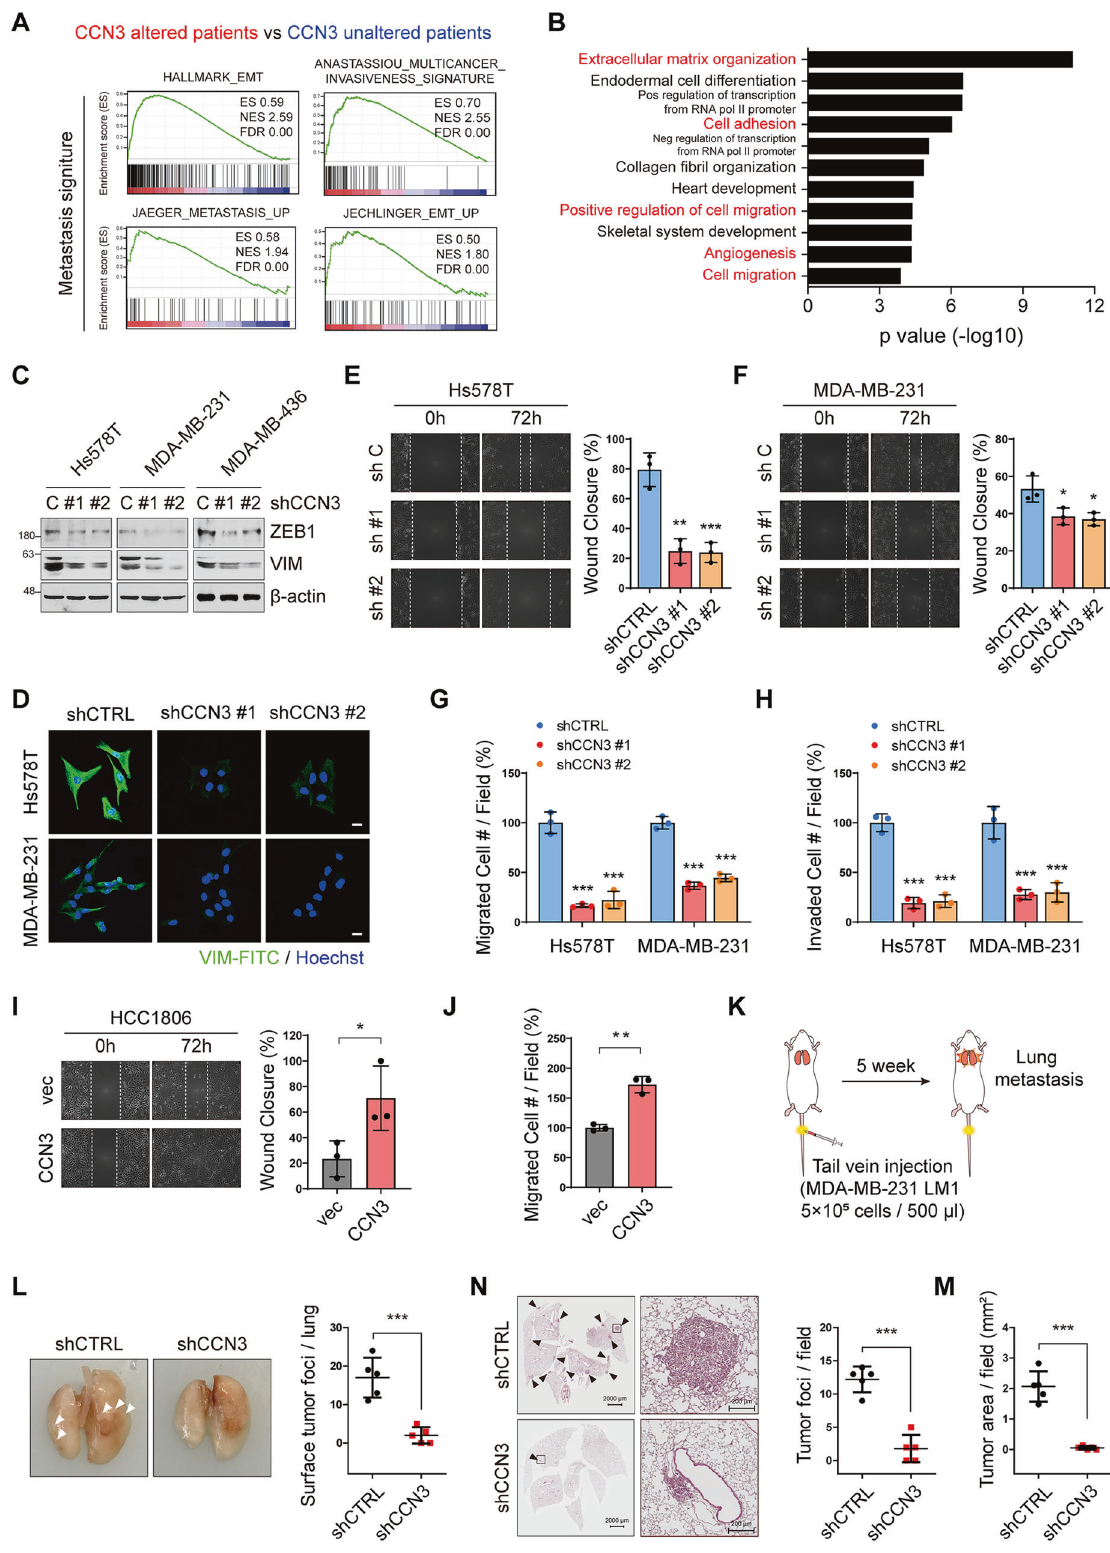
CCN3 upregulates GPNMB expression in triple-negative breast cancer To identify the molecular mechanism of CCN3-induced activation of EGFR, we performed RNA-sequencing with CCN3 knockdown Cell Death and Disease (2023)